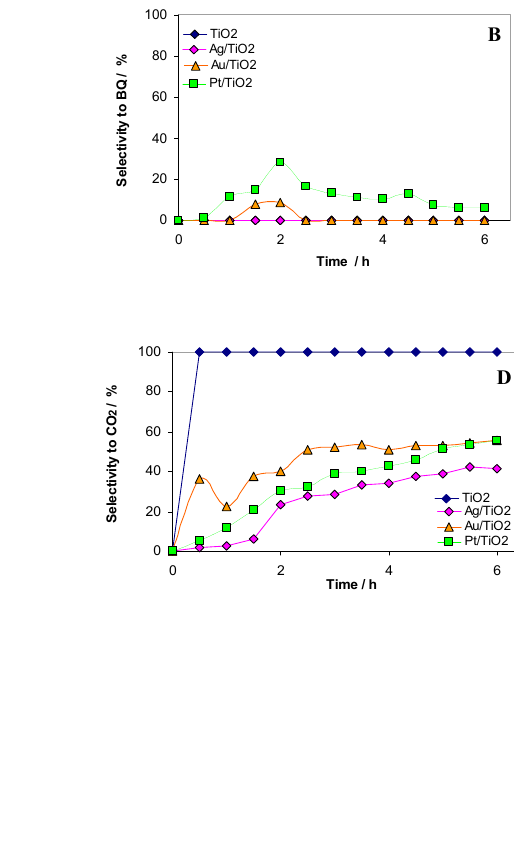
Figure 3. Solar light-driven phenol oxidative conversion to oxygenated compounds (HQ ( A ), BQ ( B ), and 1,2 DHBz ( C )), CO 2 ( D ) and to H 2 ( E ) over bare and metal modified TiO 2 synthesized by laser pyrolysis. Experimental conditions: 0.05 g suspended in 110 mL of 50 mg ∙ L − 1 phenol aqueous solution, reaction temperature 18 °C, simulated solar light AM 1.5.